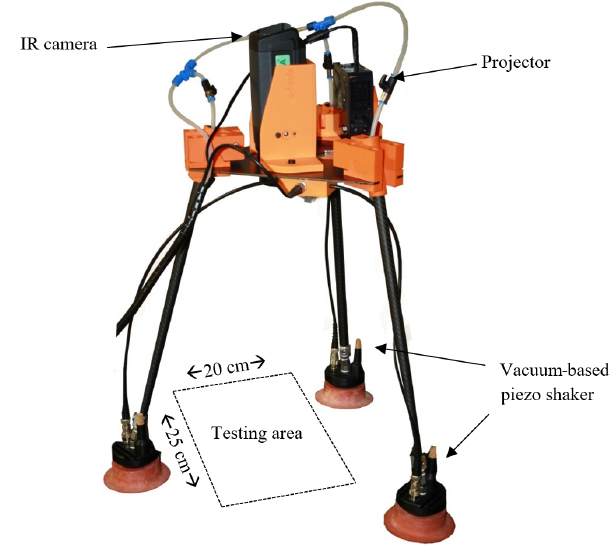
Figure 4. Prototype for a mobile RFST